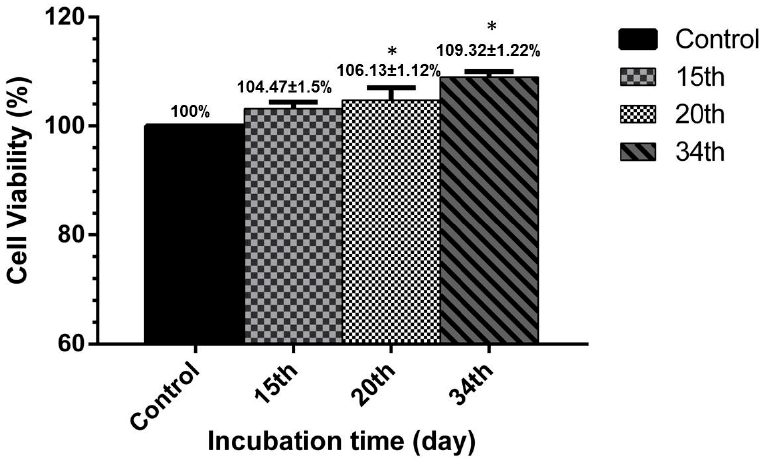
Figure 9. Results of 3D scaffold relative cell viability versus the incubation time (days). Each value is the mean ± SD of all the experiments. * p < 0.05 represents significant differences compared to the control analyzed by unpaired t -test.